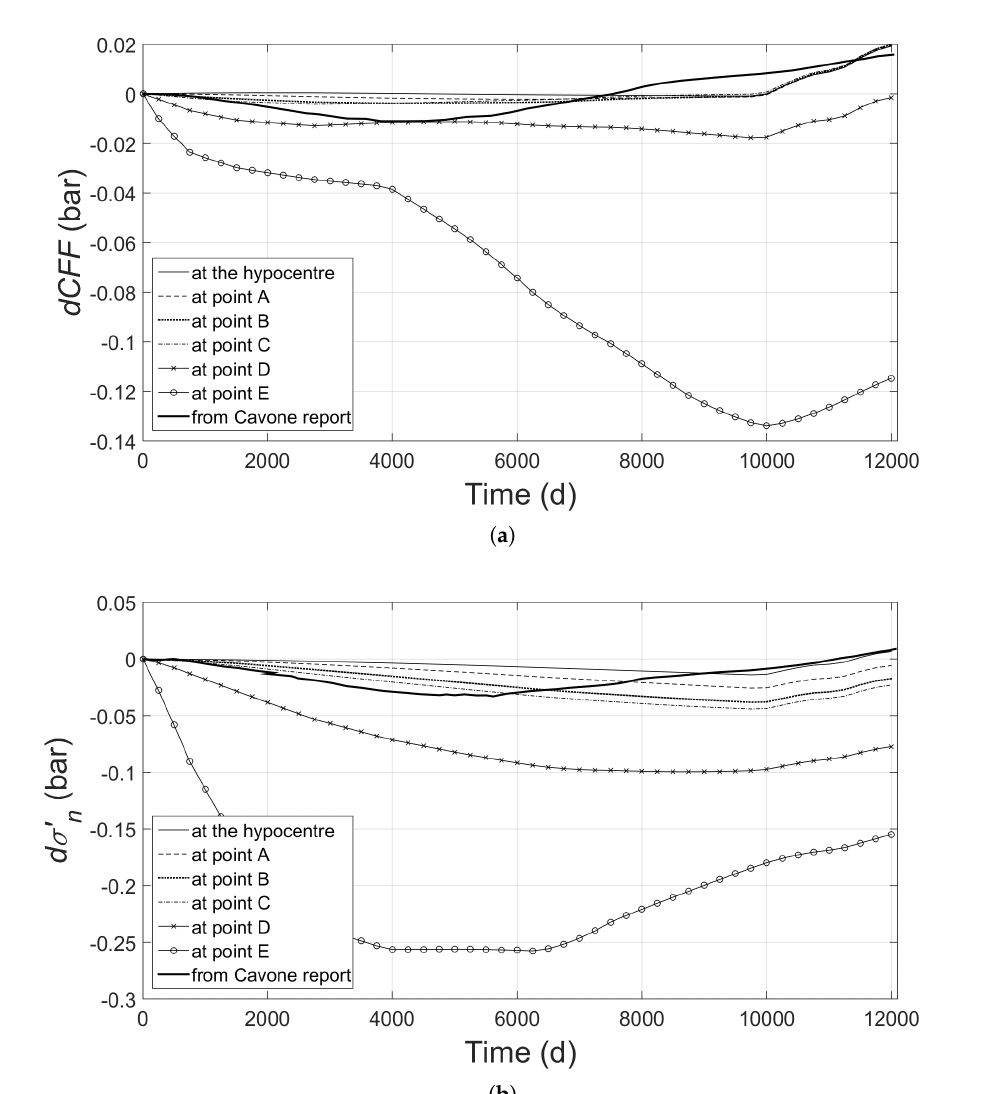
Figure 20. Emergent Mirandola fault and Cavone oilfield modeling: results at different points from the hypocentre for permeability of the lower caprock layer k lower = 0.1 mD; Coulomb stress change dCFF (bar) ( a ) and effective normal stress change d σ (cid:48) n (bar) ( b ) are plotted for different distances from the hypocentre, on the hanging-wall block (see Figure